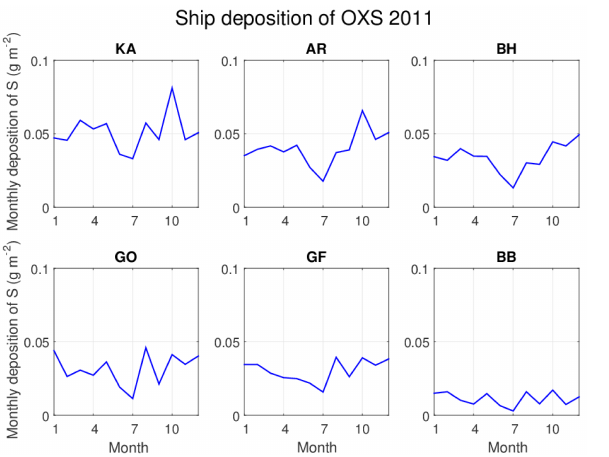
Figure 4. Monthly deposition of oxidized sulfur (OXS) in six basins of the Baltic Sea (defined in Fig.